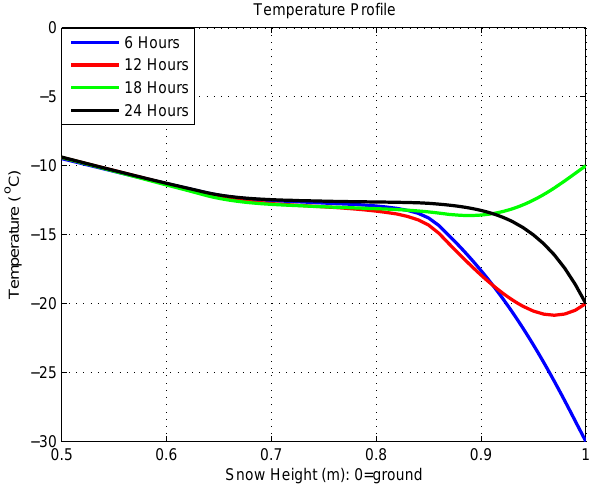
Figure 13. Snowpack temperatures over a 24h period with time dependent surface boundary conditions given by Eq. (98).